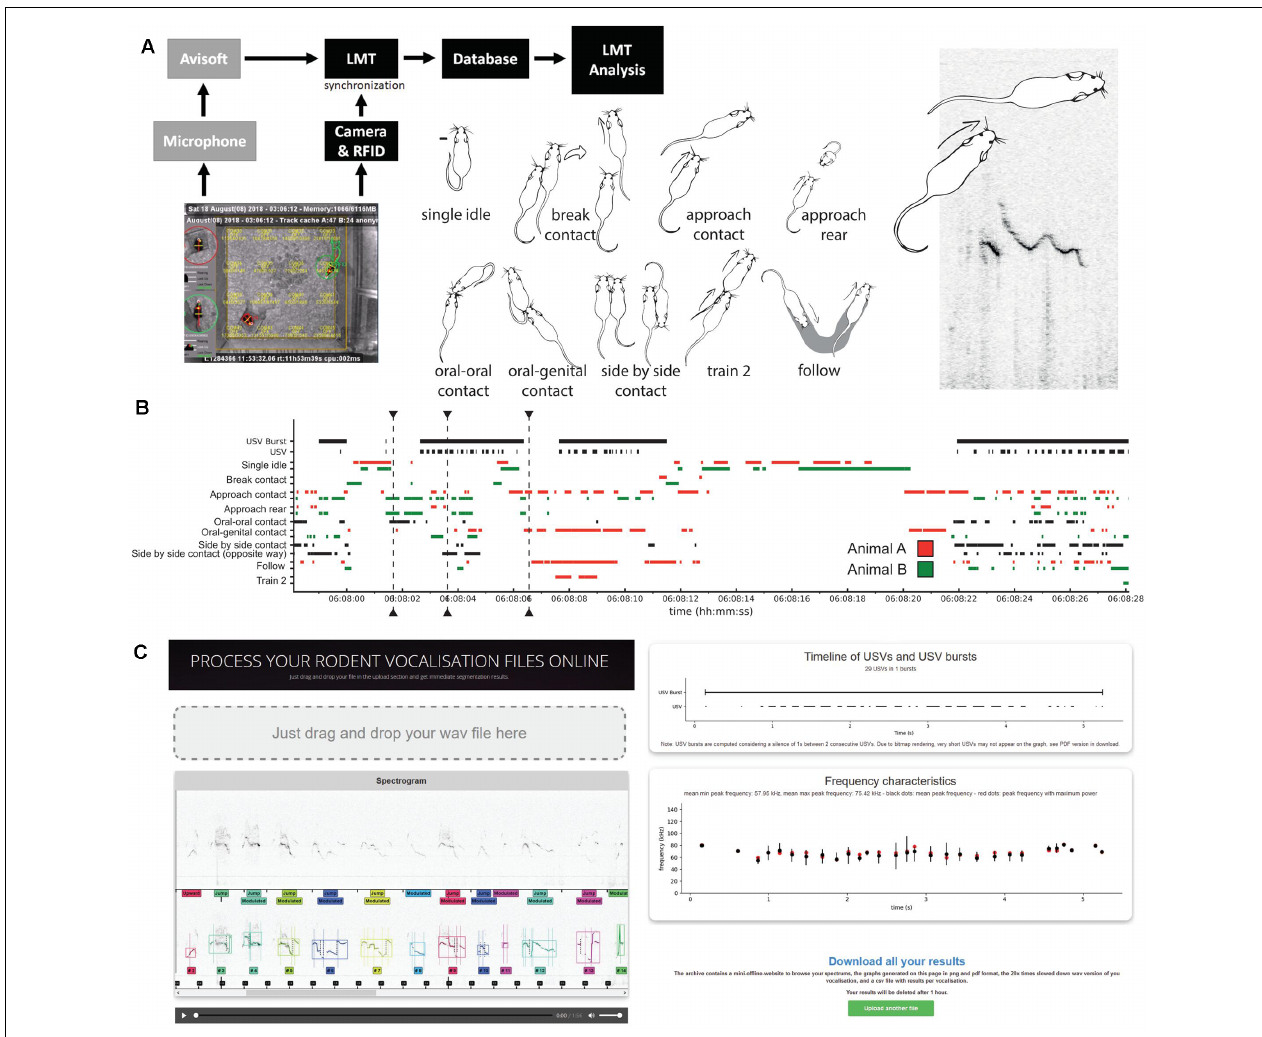
FIGURE 1 | Overview of the study of spontaneous ultrasonic vocalizations (USVs) in same-sex pairs of mice. (A) Set-up used to synchronize the spontaneous USVs and behaviors of a same-sex pair of mice using AviSoft and Live Mouse Tracker (LMT). Examples of behaviors automatically extracted using LMT; see definitions in “Materials and Methods” Section and in de Chaumont et al. (2019). (B) Timeline of 30 s of the experiment (day 1, 6 a.m.), with USVs, USV bursts, and the major behavioral events. (C) Screenshots of the online processing application (https://usv.pasteur.cloud) with an example set. Spectrogram and automatically extracted USVs in which each color labels a different USV. The segmentation follows the shape of the frequency of maximum amplitude. USV and USV burst timeline extracted, frequency characteristics. “Download all results” button providing figures and data for each acoustic feature extracted for each